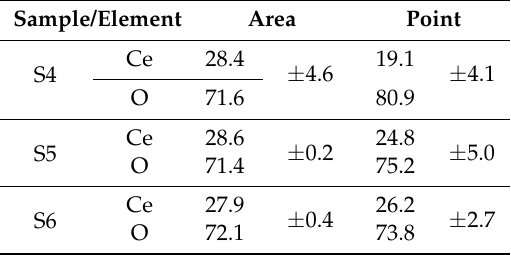
Figure 2. Left panel: SEM morphology of the cerium oxide samples S4 ( a ), S5 ( b ), and S6 ( c ). Right panel: X-ray diffraction patterns. Table 1. Mean chemical composition (at. %) of the S4, S5, and S6 samples obtained by energy-dispersive X-ray (EDX) analysis.